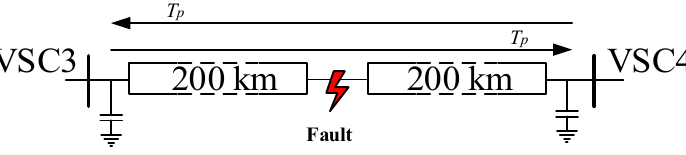
Figure 5. Propagation delay between the two ends of cable.